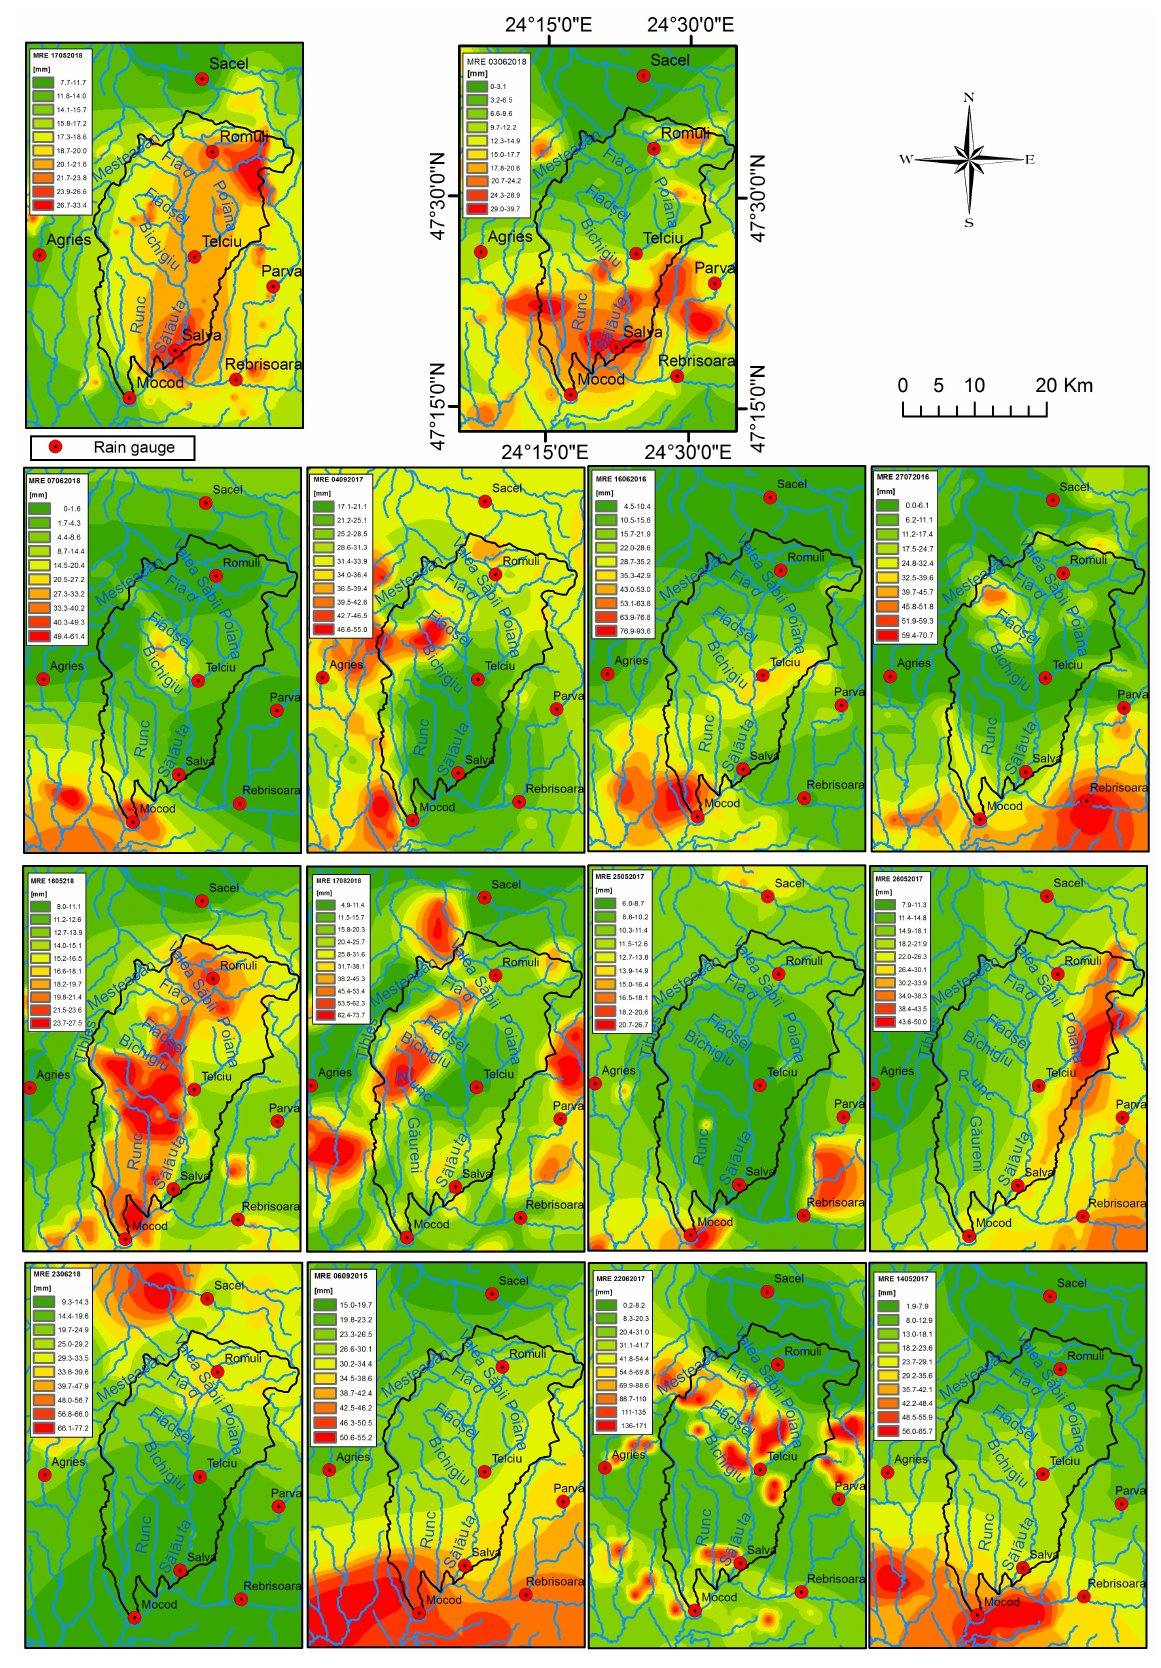
Figure 5. Merged rainfall estimates for the 15 studied